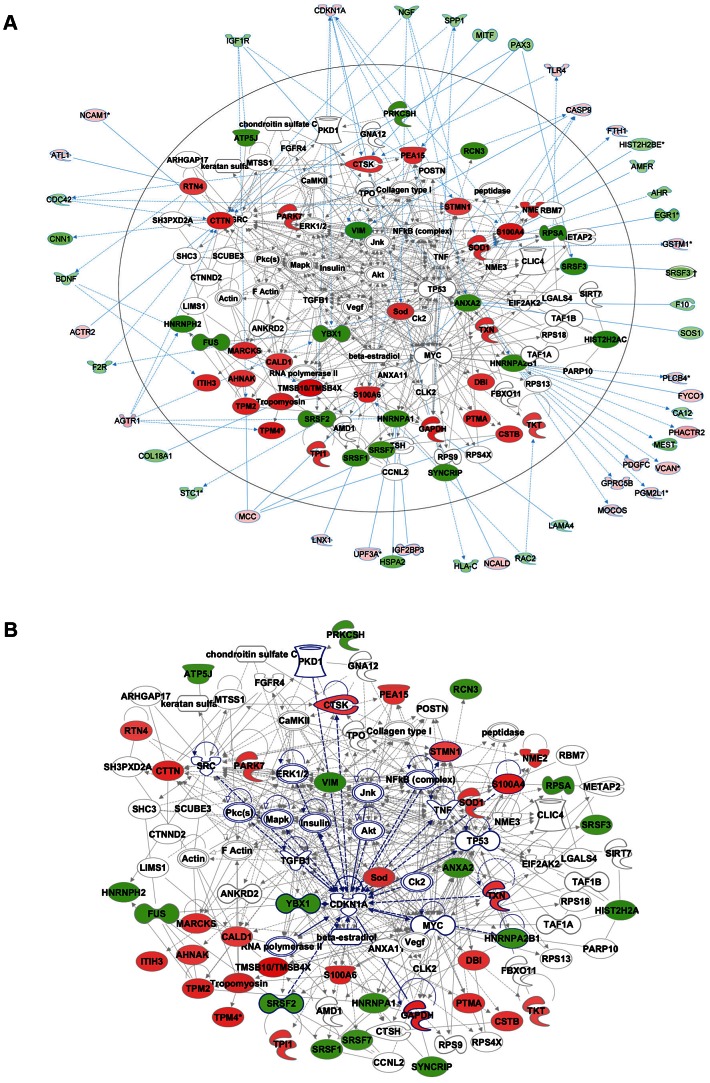
Comparative proteomics and global gene expression profiling reveals a central role of p21 activation in ACC.a. The two top-ranked networks were merged to generate a combined network of the differentially present proteins in ACC fibroblasts (center). Differentially expressed genes identified in the transcript profiling microarray experiments are indicated in the periphery of the proteomic network, and interactions are illustrated by arrows. This analysis revealed the highest number of interactions to include p21 (CDKN1A) and hnRNPA2B1. b. Interaction analysis among p21 (CDKN1A) and the entire merged proteomic network revealed a central role of p21, showing that p21 activation is a central determinant of the ACC phenotype.